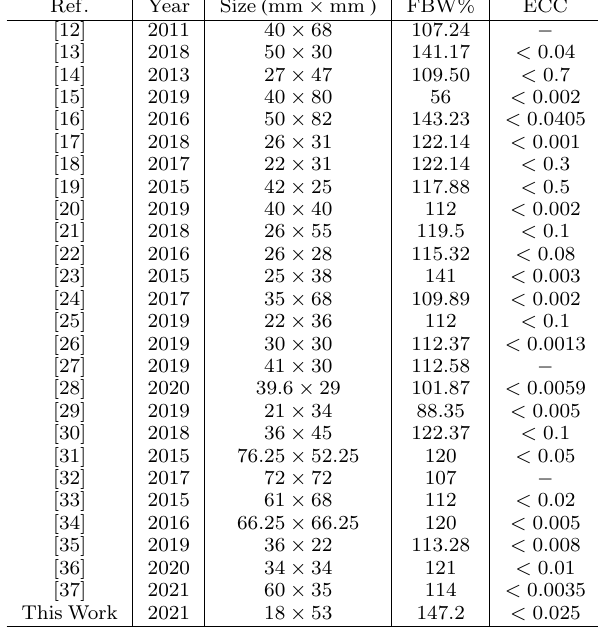
TABLE 2: A comparison of previously developed MIMO antennas and the proposed antenna Ref